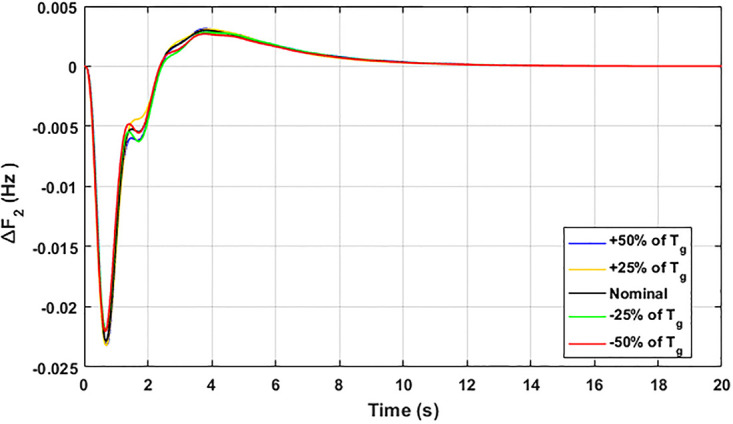
Results for variation in Tg with ΔF2.